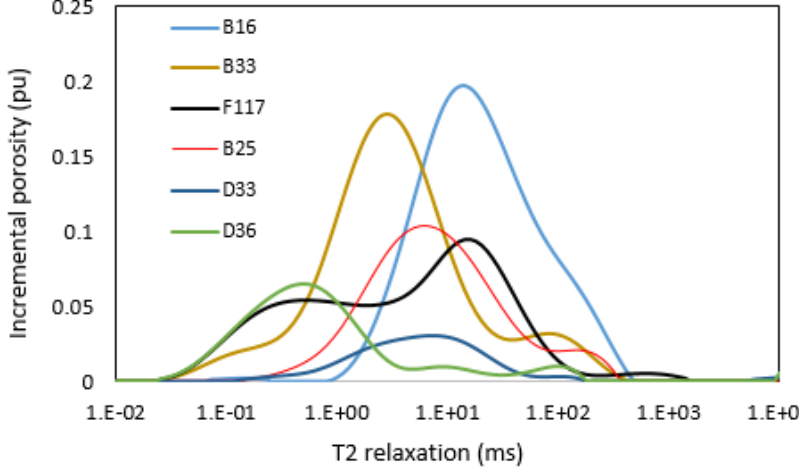
Figure 12. Distribution of NMR T 2 relaxation for subsamples in porosity group 1 (<7%).